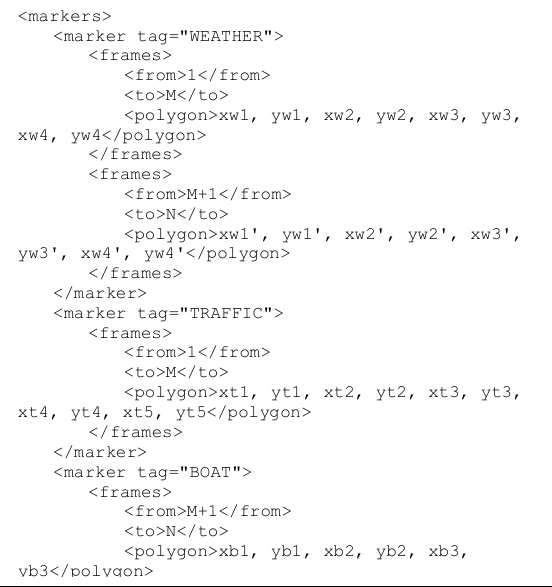
Figure 6. XML file sample for video markers